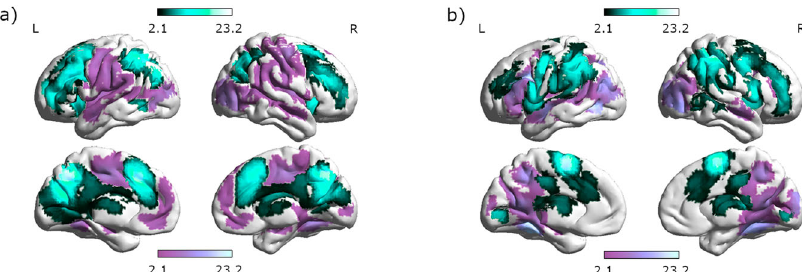
Fig. 1 Modulation of brain activation by perspective and strategy. a Differential activation between allocentric and egocentric navigation. Areas with stronger activation for allocentric compared to egocentric navigation are displayed in turquoise. Areas with stronger activation for egocentric compared to allocentric navigation are displayed in purple. b Differential activation between Euclidian-based and landmark-based navigation. Areas with stronger activation for Euclidian compared to landmark-based navigation are displayed in turquoise. Areas with stronger activation for landmark-based compared to Euclidian navigation are displayed in